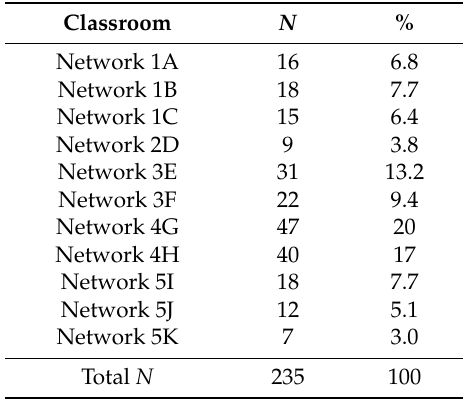
Table 2. Student distribution by participating network in the